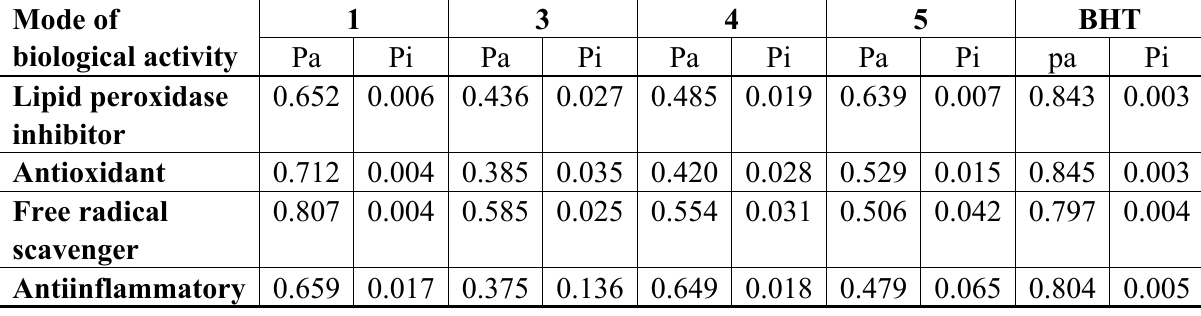
Table 4. Part of the predicted biological activity spectra for the compounds 1 , 3–5 and